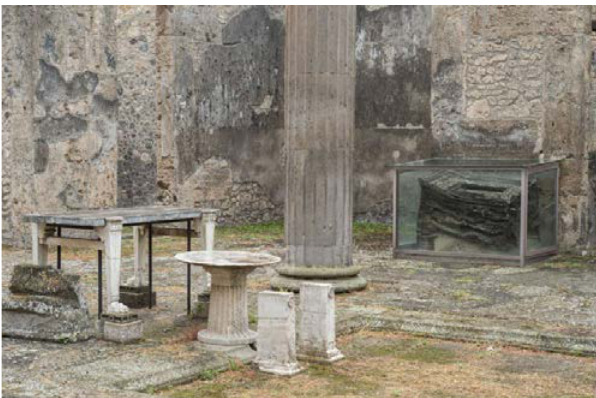
Figure 3. The main atrium at the entrance of the Obellio Firmo domus : the safe is clearly visible in the background (from pompeiisites.org official Twitter